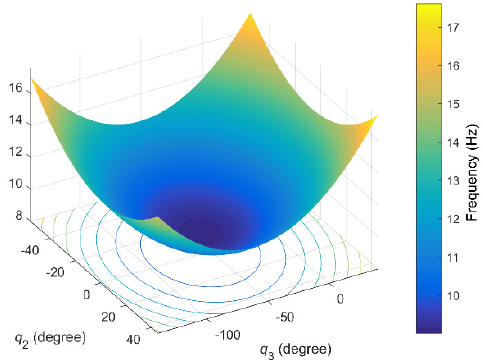
Figure 11. Variation of natural frequency with q 2 and q 3 .